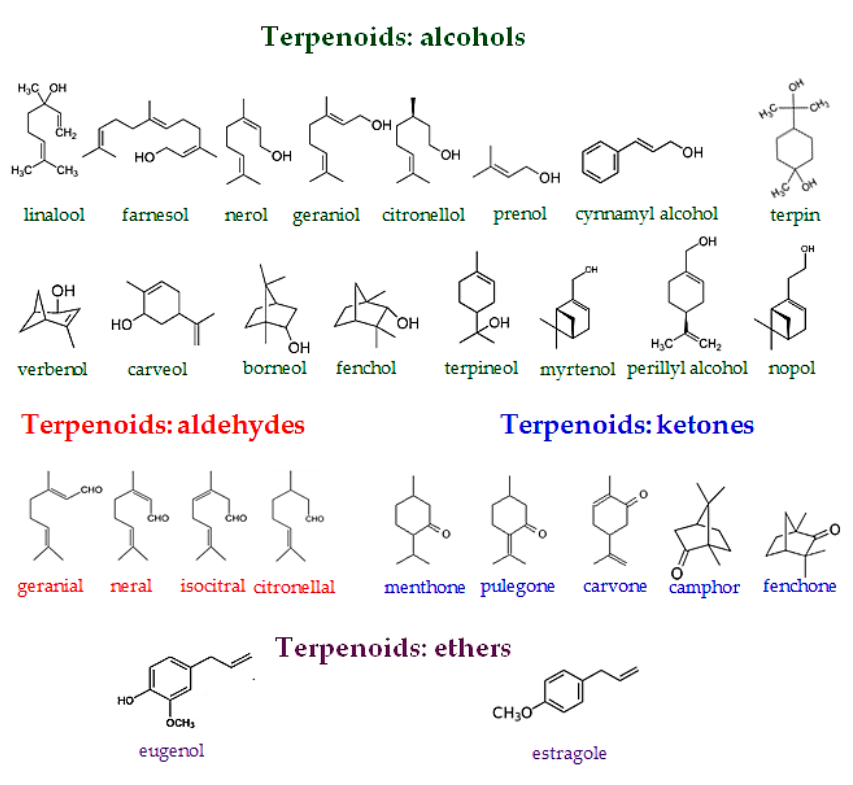
Figure 2. The main available terpenes and terpenoids.